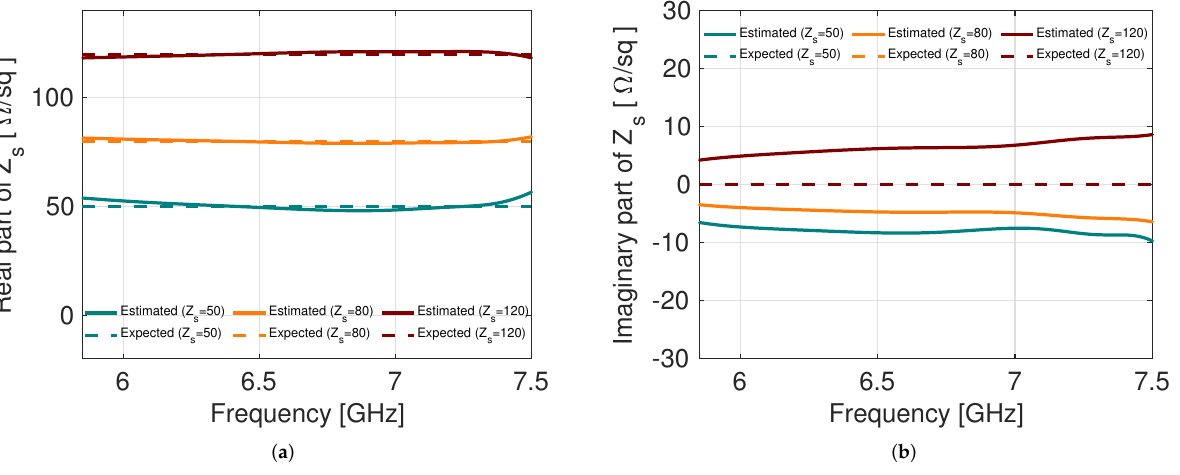
Figure 5. ( a ) Real part of the surface impedance; ( b ) imaginary part of the surface impedance when a 100 Ω /sq impedance sheet has been used for